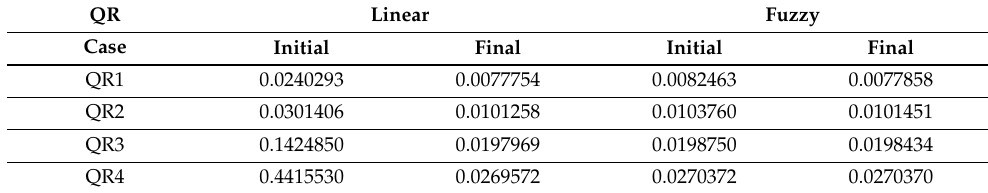
Figure 18. Control signal and response for a unitary reference. Table 3. Initial and final values for J T in each configuration.